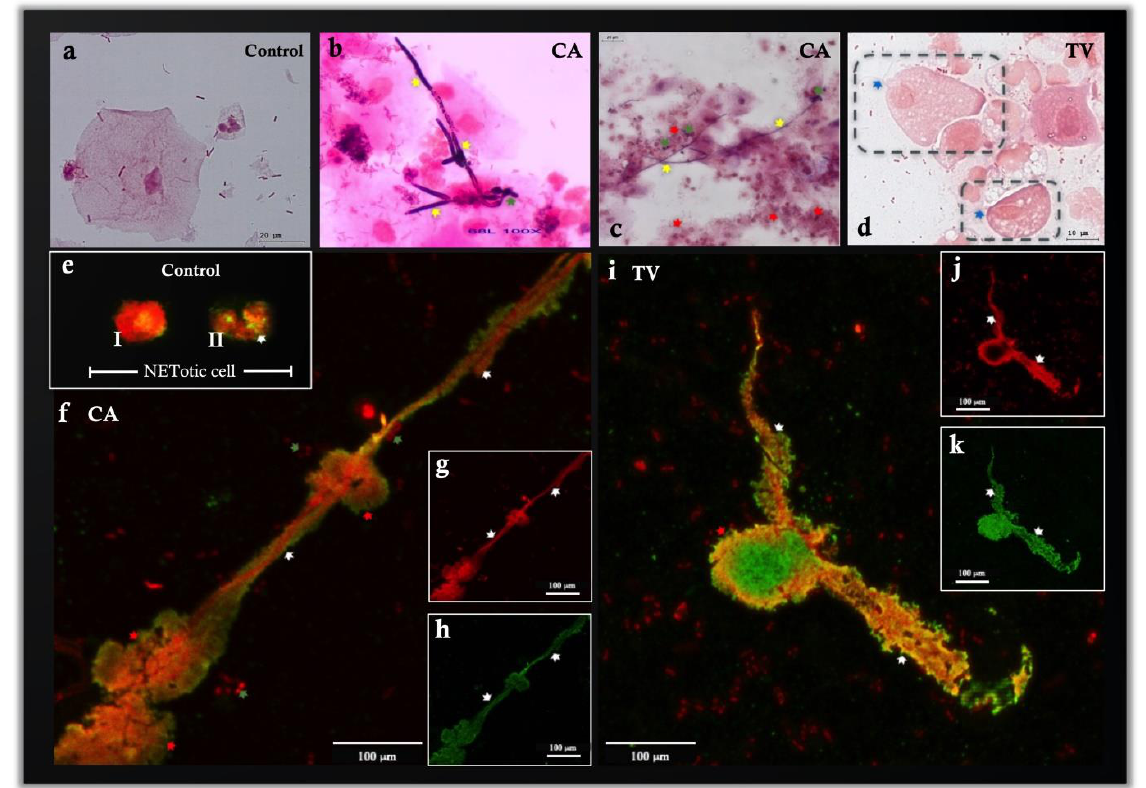
Figure 2. Representative images of pathological vaginal discharges. ( a ) Control group; ( b , c ) Gram staining of vaginal discharges with the presence of blastoconidia and pseudohyphae (corresponding to CA diagnosis using PCR). The dark purple stain shows pseudohyphae at 100× magnification. ( d ) TV in Gram staining. ( e ) Immunofluorescence of pathological vaginal discharges with neutrophils releasing NETs. Neutrophils activated by NETosis are shown in the control group with differing degrees of activation: I, compact nucleus; II, nucleus beginning to decondense. ( f , i ) neutrophils releasing NETs at a greater magnification (100× magnification, 100% zoom). ( g , j ) Extracellular DNA in red (Sytox Orange). ( h , k ) Neutrophil elastase in green (Alexa fluor 488). Yellow arrows indicate pseudohyphae, green arrows indicate blastoconidia, red arrows indicate PMN, white arrows indicate NETs, blue arrows indicate flagella of TV, and the outline in black indicates TV.